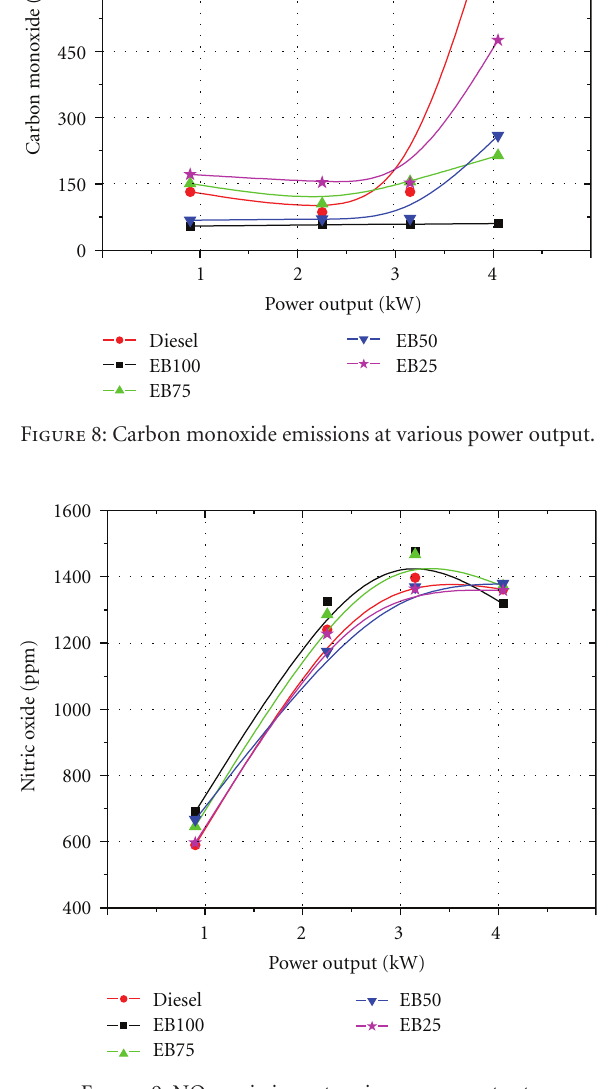
Figure 9: NOx emissions at various power